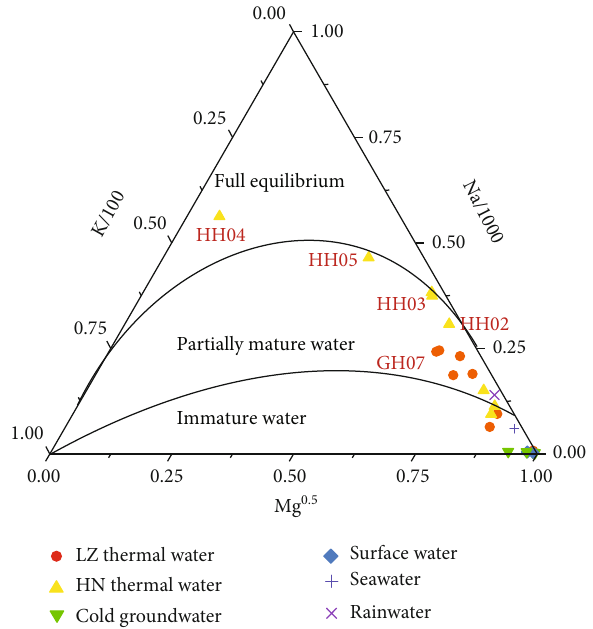
Figure 9: Giggenbach diagram showing relative Na/1000, K/100, and Mg 1/2 contents (mg/L) based on the water samples from the LZ and